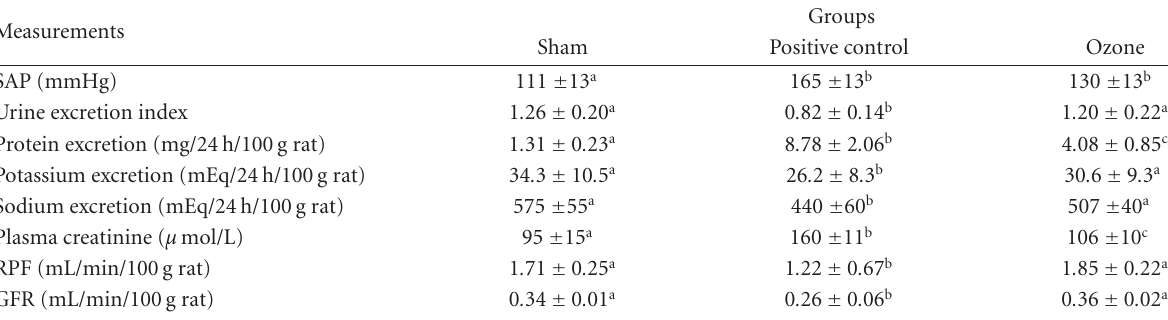
Table 1. Behavior of the systolic arterial pressure (SAP); urine excretion index; protein, potassium, and sodium excretions; creatinine figures; renal plasmatic flow (RPF); and glomerular filtration rate (GFR), at the end of the study, in the di ff erent groups. Data are mean ± SD. a , b , and c denote statistical significance of at least P < . 05.